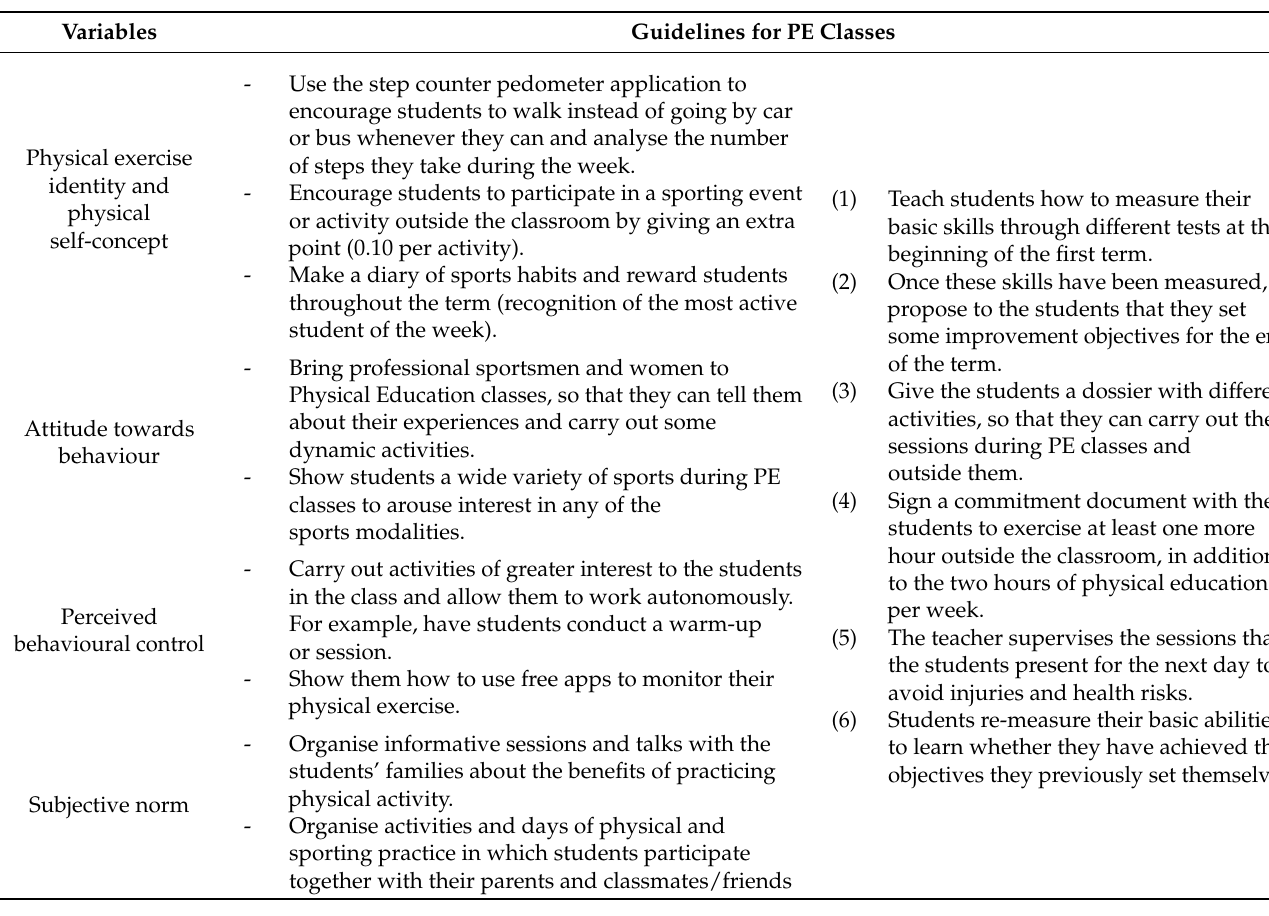
Table 6. Guidelines to promote physical self-concept, physical exercise identity, attitude towards behaviour, and perceived behavioural control in PE